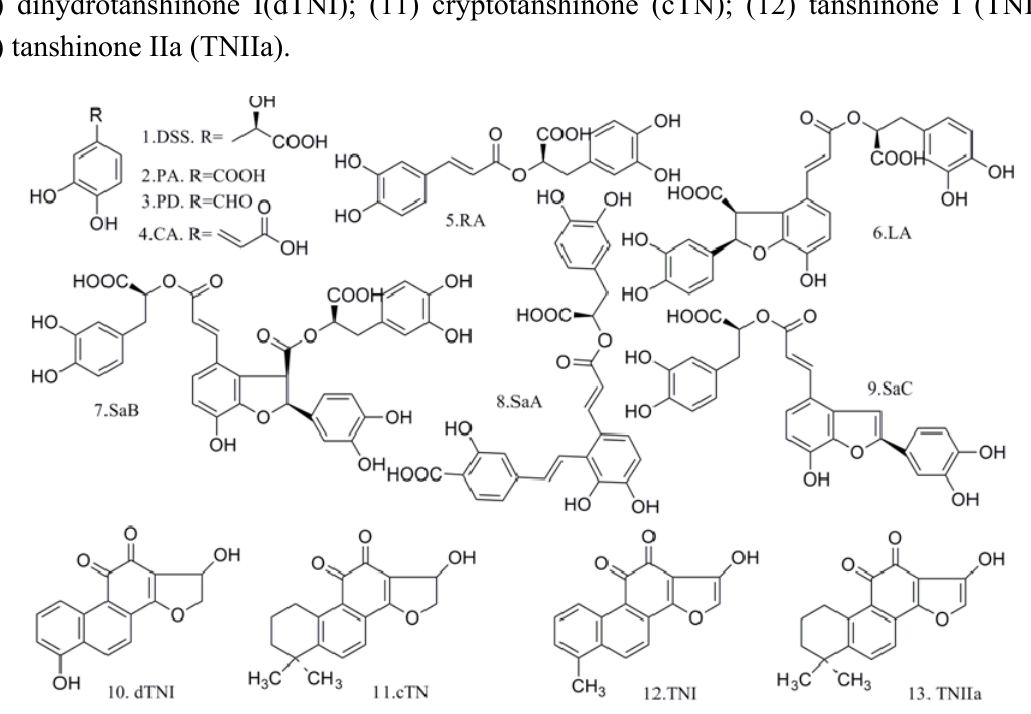
Figure 1. Chemical structures of the major bioactive components in